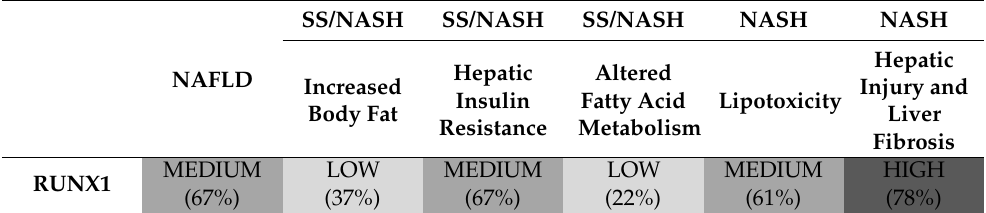
Table 1. ANNs score of the relationship between RUNX1 and NAFLD, both globally and for each NAFLD